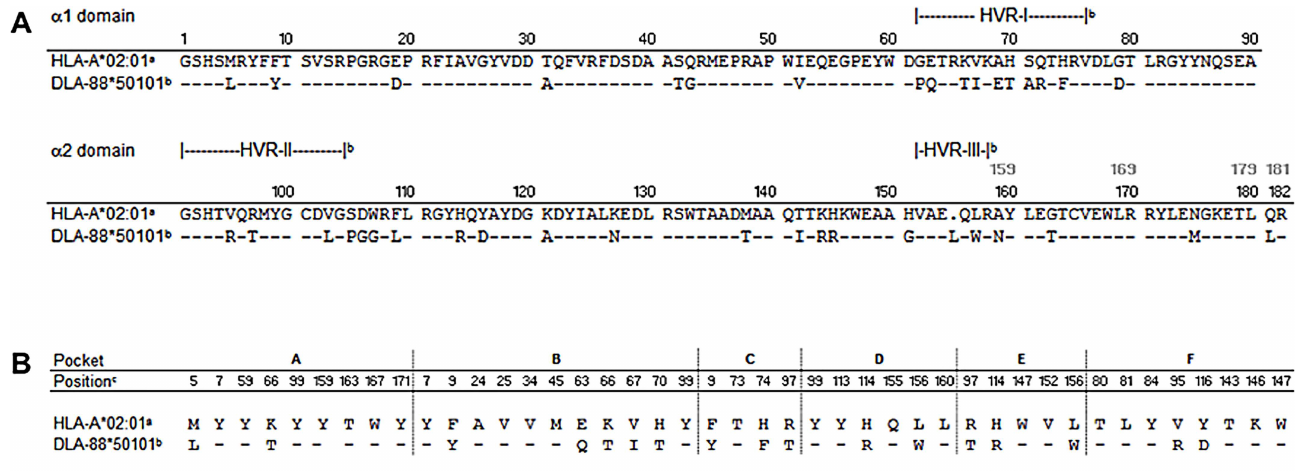
Fig 3. Alignment of MHC class I α 1 and α 2 domain amino acid sequences of HLA-A * 02:01and DLA-88 * 50101. (A) Alignment of MHC class I α 1 and α 2 domain amino acid sequencesof human (HLA-A * 02:01; AAA76608.2 a ) and dog (DLA-88 * 50101; AF100577, AF101496,[19] b ). Identity of amino acid sequencesto humanHLA-A * 02:01is shownby dashes, disposability of data is illustratedby a dot. Position numbers for DLA-88 * 50101 are indicatedin black above the sequences. Deviatingpositionnumbers for HLA-A * 02:01 resultingfrom the amino acid deletionare given in grey bold type on top of the correspondingDLA-88 * 50101position.Residuesallocatedto hypervariableregionsI-III are indicatedabovethe alignment ([19] b ). (B) Comparisonof selectedresidues of HLA-A * 02:01 (AAA76608.2 a ) and DLA-88 * 50101 (AF100577,AF101496,[19] b ) with reference to pockets A-F. The indicatedpositions refer to HLA-A * 02:01 ([39–41] c ). For DLA-88 * 50101,corresponding positionsare shifted by one amino acid starting with the C-terminal of position 154, due to an amino acid insertion[44].